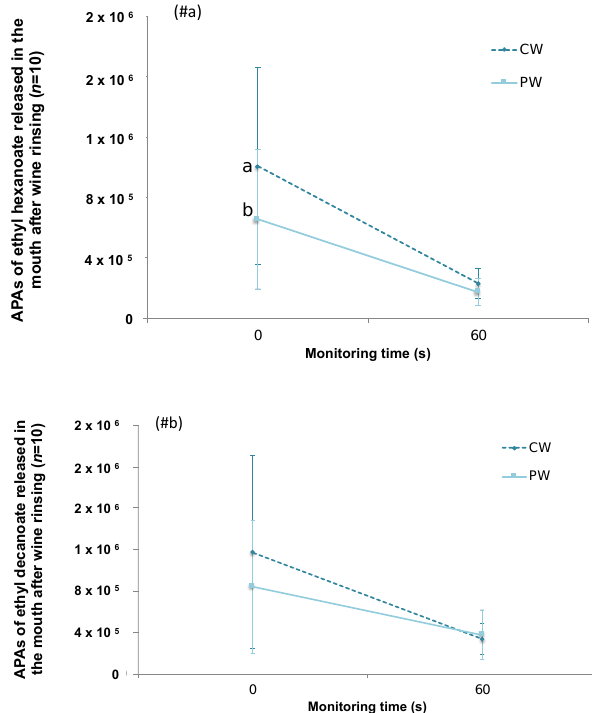
Figure 2. Comparison of the absolute peak areas (APAs) of ethyl hexanoate ( #a ) and ethyl decanoate ( #b ) released in the mouth after oral rinsing with the control wine (CW) and with the wine with the GSE added (PW) using in vivo conditions. Different letters across the different time points indicate significant differences between wines ( p < 0.05, α < 0.05).